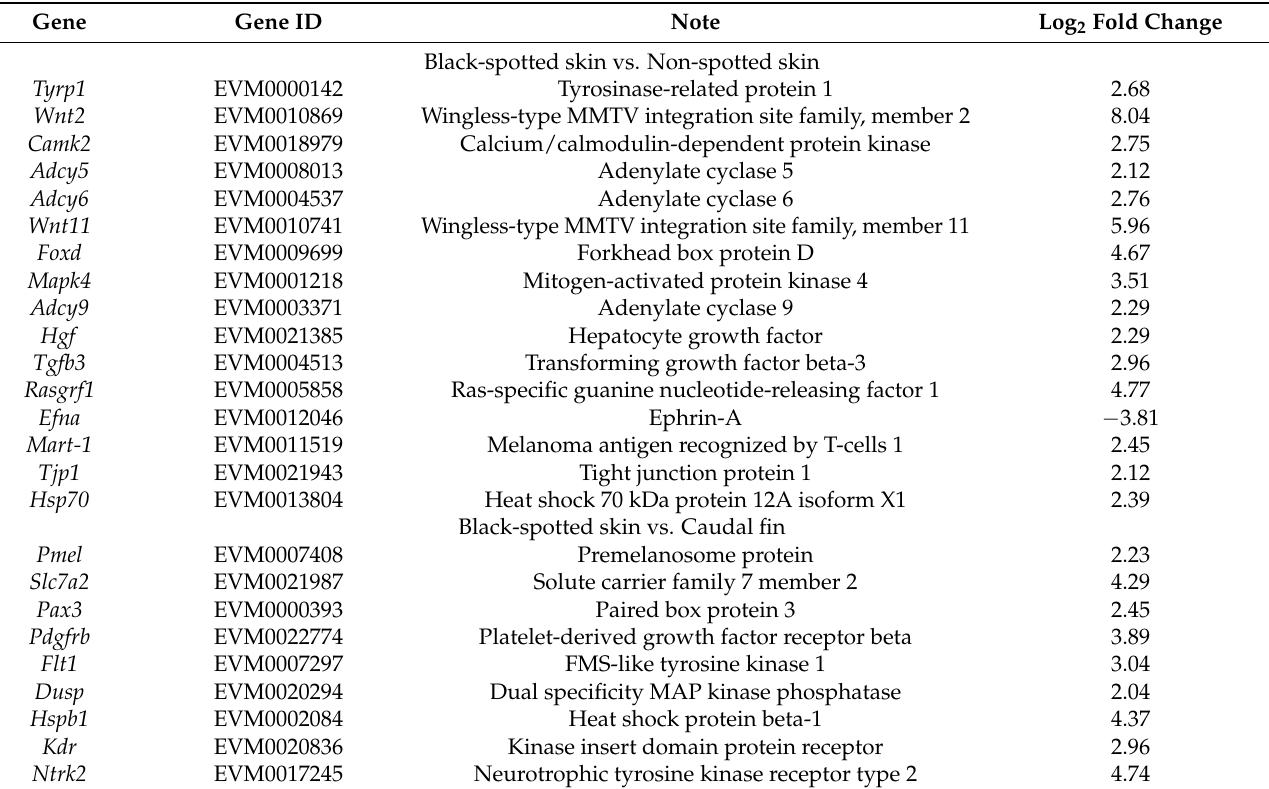
Table 2. Analysis of differentially expressed genes (DEGs) related to